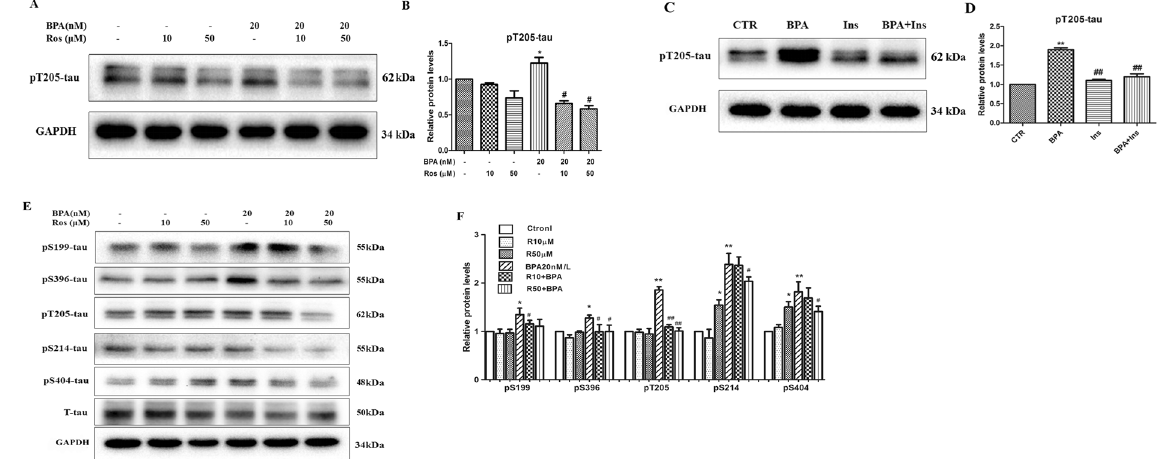
Figure 7. Effects of rosiglitazone and insulin on BPA-induced tau phosphorylation. ( A ) Effect of rosiglitazone on the expression of phosphorylated tau mediated by BPA in SY5Y cells. ( C ) Effect of insulin on the expression of phosphorylated tau mediated by BPA in SY5Y cells. ( E ) Effect of rosiglitazone on the expression of phosphorylated tau mediated by BPA in PC-12 cells. ( B , D , F ) GAPDH levels were assessed in parallel and served as controls. Mean values ± SEMs are representative of three independent isolations and three independent samples. Significant differences between the treatment groups and the control group were determined via one- way ANOVA and the Dunnett multiple comparison procedure. ( * P < 0.05, ** P < 0.01 compared with the BPA single treatment group, # P < 0.05, ## P <